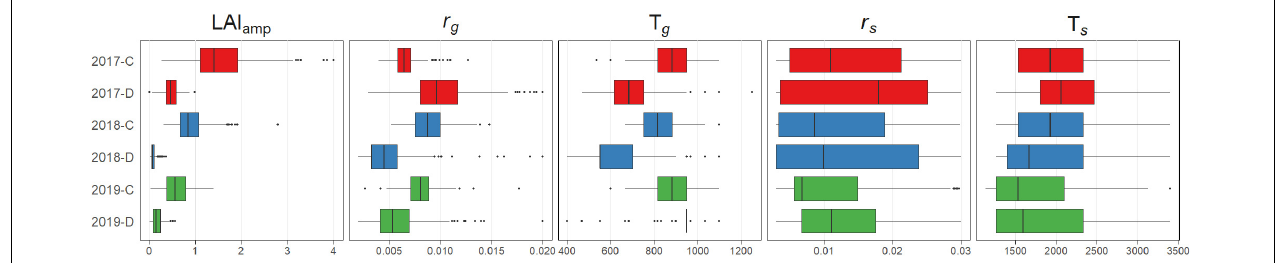
FIGURE 6 | Boxplot of estimated growth